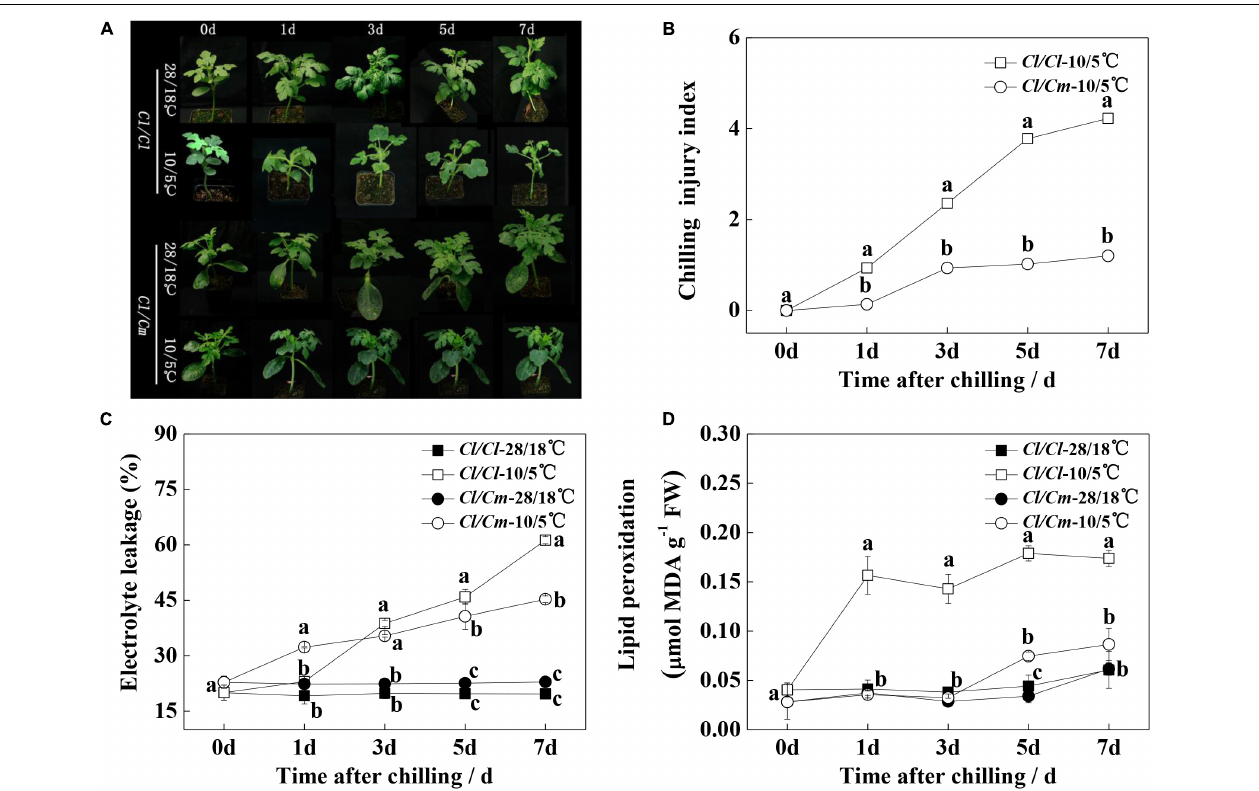
FIGURE 1 | Effects of pumpkin rootstock on the chilling tolerance of watermelon seedlings. (A) Representative images of chilling phenotypes. (B) Chilling injury index. (C) Electrolyte leakage. (D) Malondialdehyde (MDA) content. Values are means ± SE ( n ≥ 4). Different letters indicate the significant differences among various treatments at the same time ( P < 0.05, one-way